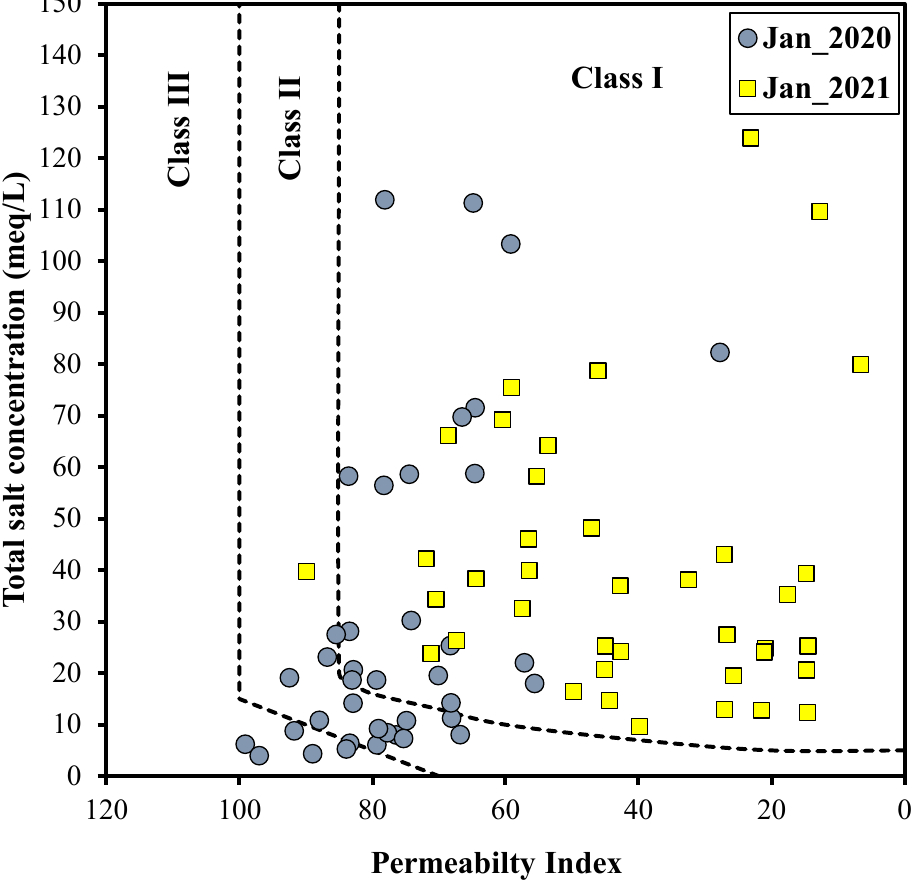
Figure 6. Doneen‘s plot of soil permeability for irrigation water quality.